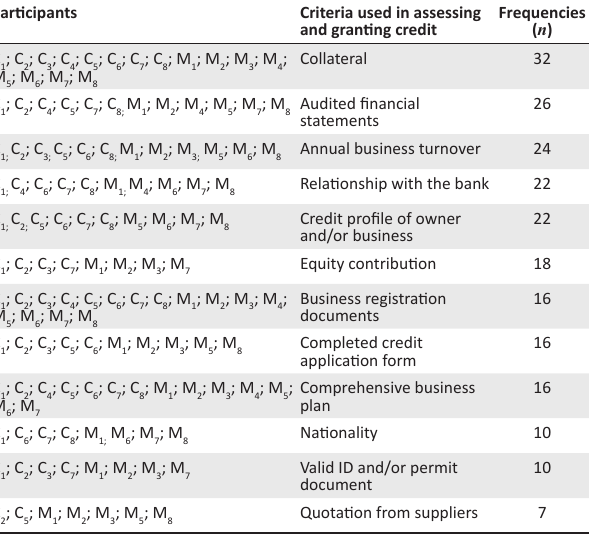
TABLE 3: Perspective of participants on the criteria used by formal financial institutions in assessing and granting credit to small and medium enterprises. Participants Criteria used in assessing and granting